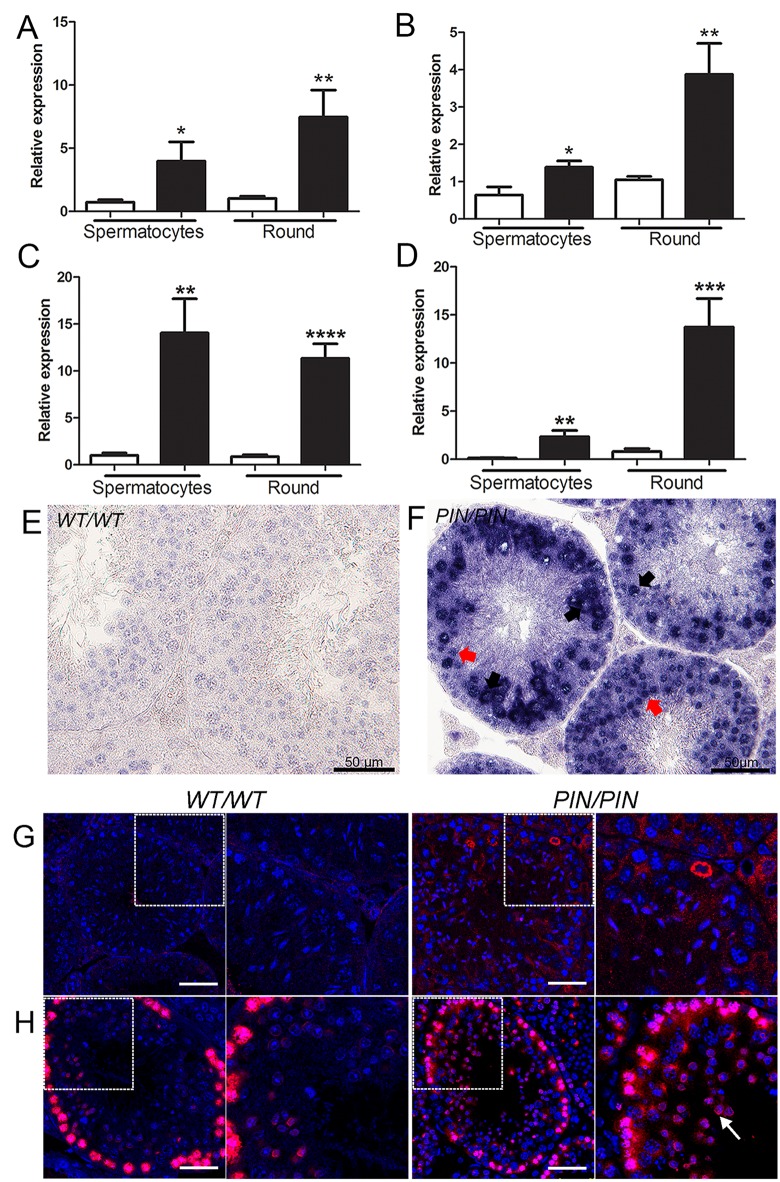
HENMT1 is required for the repression of Line-1 and IAP retrotransposons in spermatocytes and round spermatids.
(A-D) qPCR analyses of (A) L1_A (B) L1_TF14 (C) IAP_LTR (D) IAP_GAG in Henmt1
WT/WT and Henmt1
PIN/PIN spermatocytes and round spermatids (round) purified from 30 day old mice. A two-tailed unpaired student T-test was performed for statistical analysis, n = 5/genotype, +/- SEM, * p<0.05; ** p<0.01; ***p<0.001; ****p<0.0001. (E-F) RNA in situ hybridisation for Line-1 expression in Henmt1
WT/WT and Henmt1
PIN/PIN 10 weeks-old testes. Black arrows indicate pachytene spermatocytes. Red arrows indicate round spermatids. (G) Staining for LINE-1 in in Henmt1
WT/WT and Henmt1
PIN/PIN in 10 weeks-old testes. The boxed areas are magnified in the panel to the immediate right of each genotype. The scale bar = 50 μm. (H) Immunofluorescence staining for γH2AX (red) as a marker of DNA double stranded break respectively in Henmt1
WT/WT and Henmt1
PIN/PIN in 10 weeks-old testes. The white arrow indicates elevated γH2AX staining in spermatids compared to wild type cells. The boxed areas are magnified in the panel to the immediate right of each genotype. The scale bar = 50 μm.